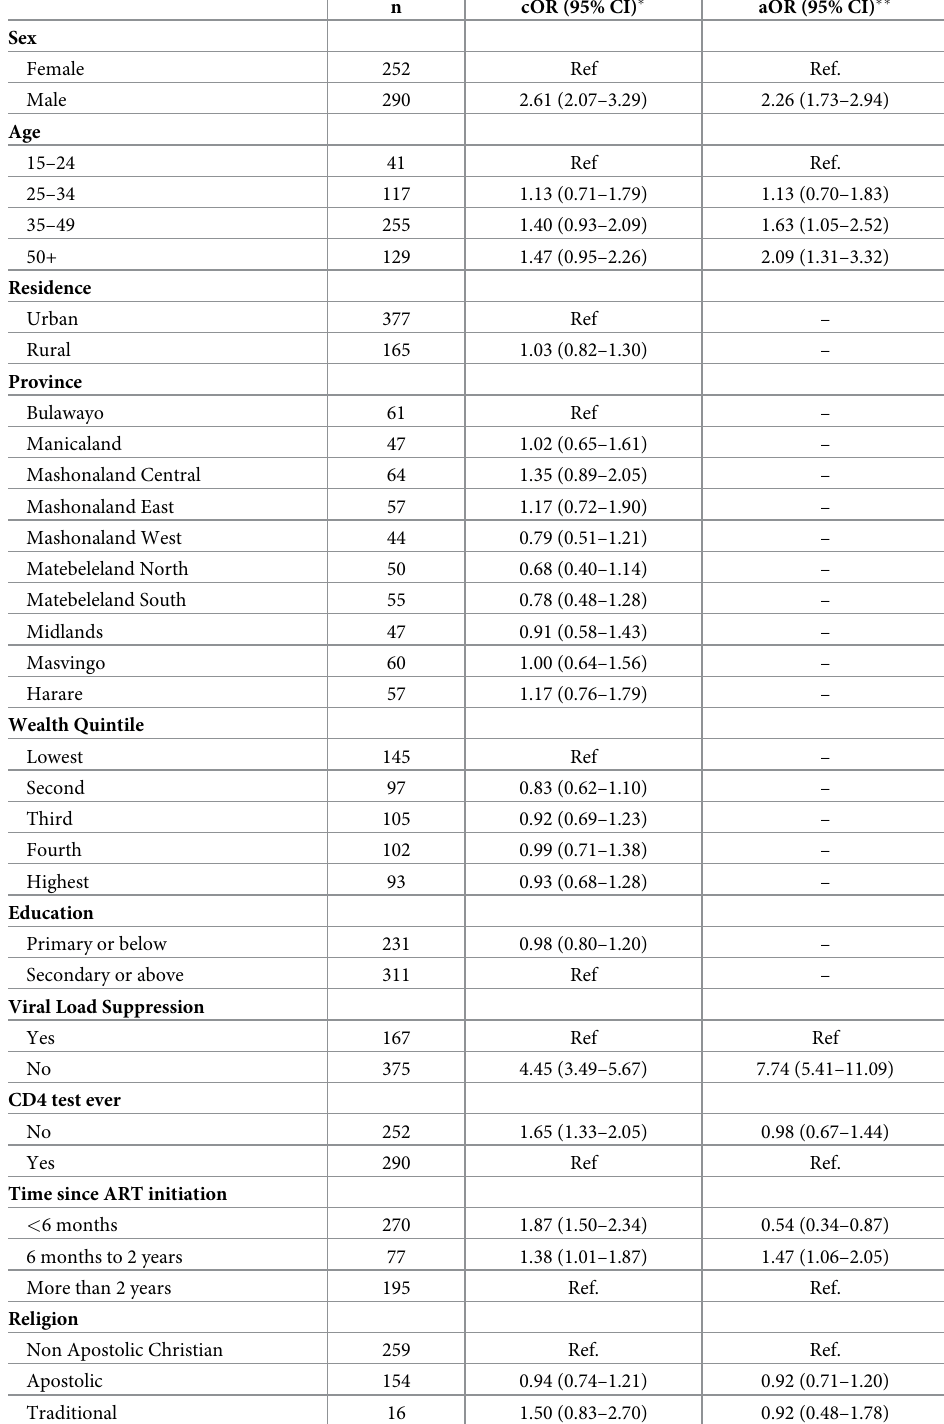
Table 2. Results of bivariate and multivariable models for advanced HIV disease (CD4 < 200 cells/mm 3 (n =